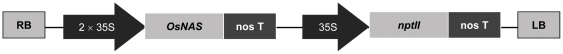
Schematic representation of the T-DNAs used for constitutive overexpression of the three OsNAS genes.RB, right border; 2 × 35S, dual CaMV 35S promoter; OsNAS, coding sequence of OsNAS1 (999 bp), OsNAS2 (981 bp) or OsNAS3 (1032 bp); nos T, nopaline synthase terminator; 35S, CaMV 35S promoter; nptII, neomycin phosphotransferase II; LB, left border.